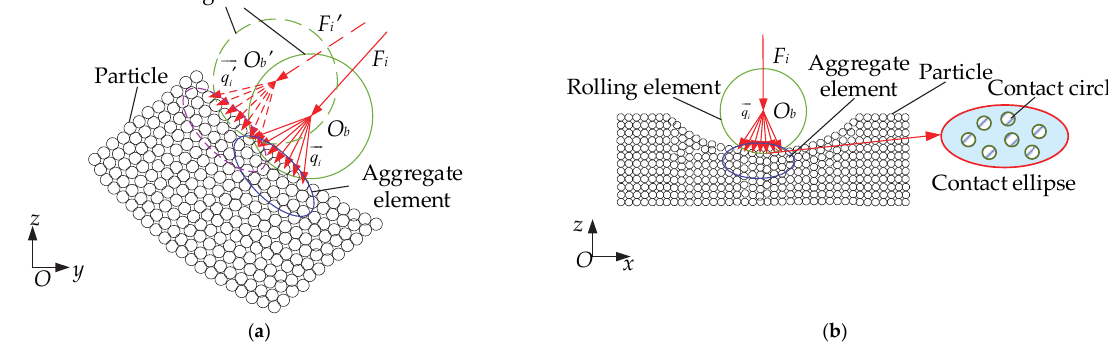
Figure 5. Rolling element in contact with the discrete outer raceway: ( a ) axial; ( b ) radial.